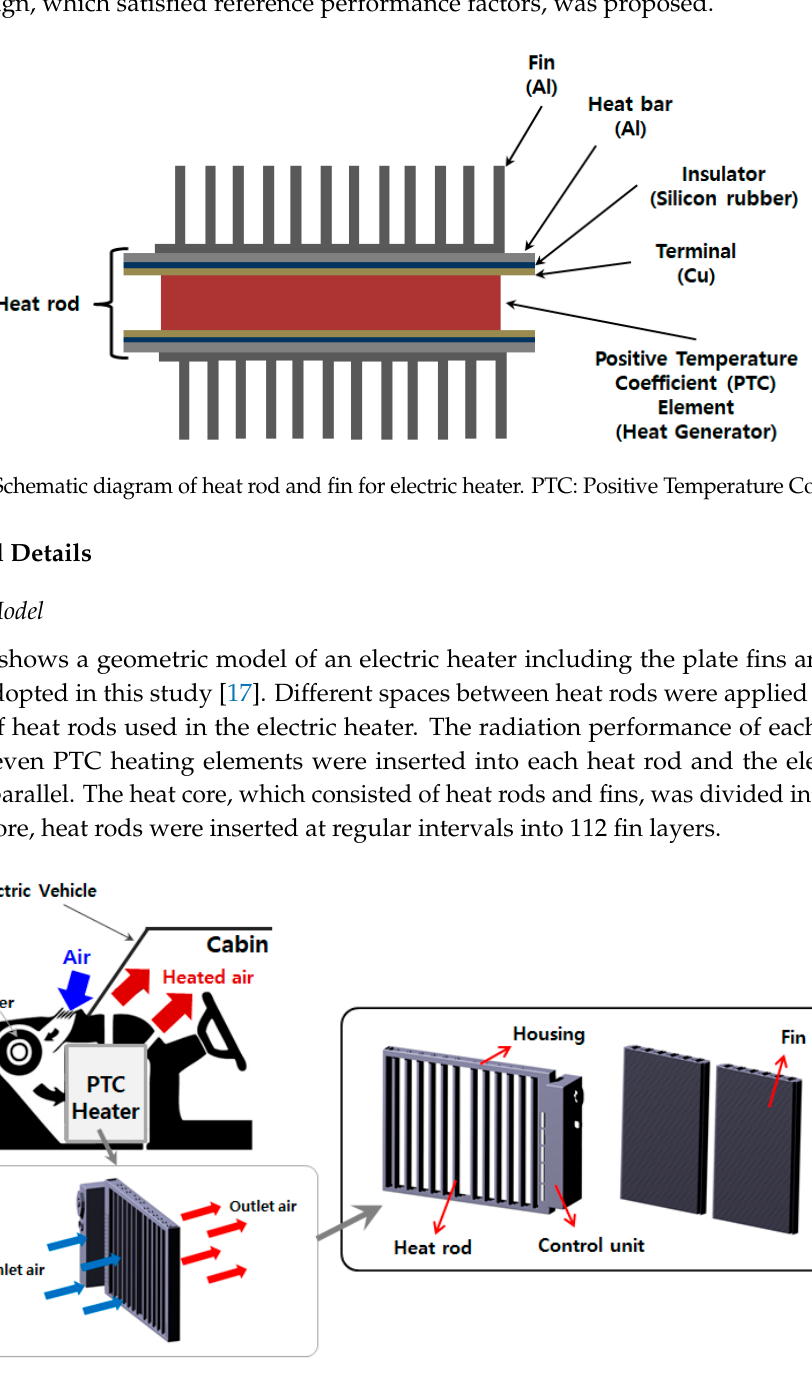
Figure 2. Schematic diagram of PTC heater in an electric vehicle (geometry of housing, heat rod, and fin array).